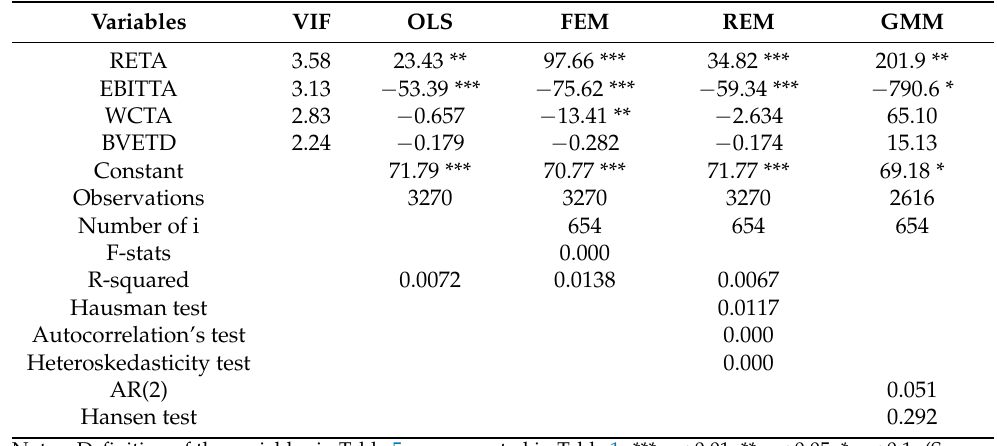
Table 5. Regression results of effects of retained earnings, earnings before interest and tax, working capital, and book value of equity to total debt to time of annual reports publication (model